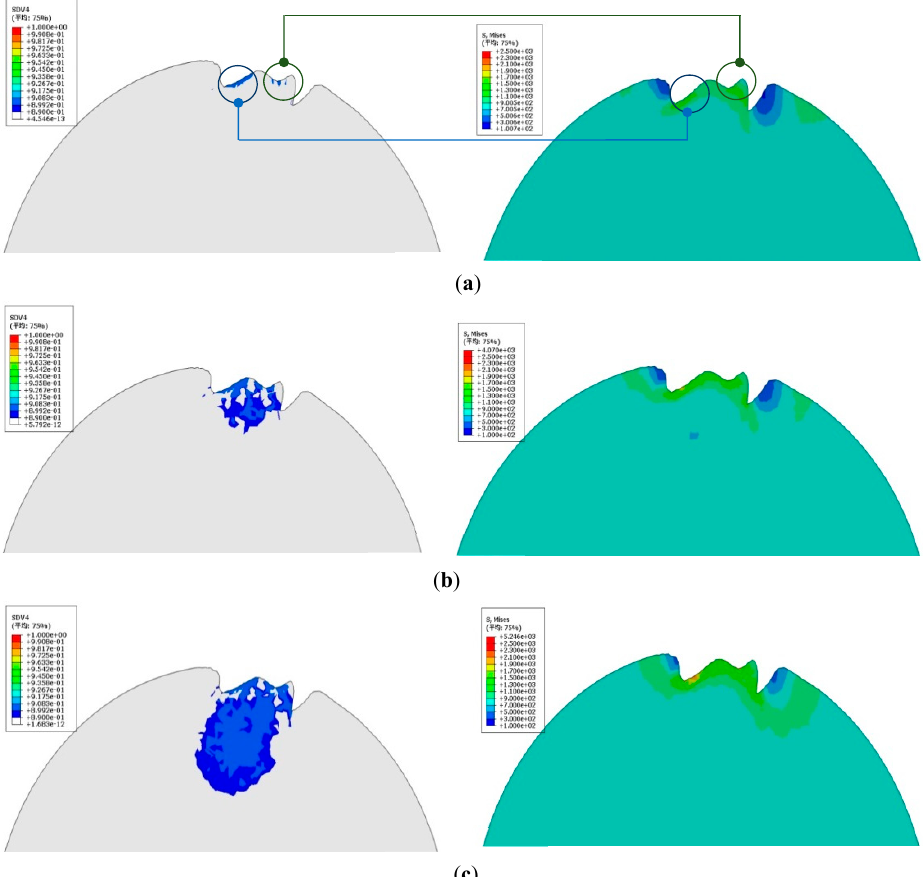
Figure 11. Damage evolution process and stress distribution of pre-corroded steel wire on a cross section. ( a ) step = 51; ( b ) step = 151; ( c ) step = 195.